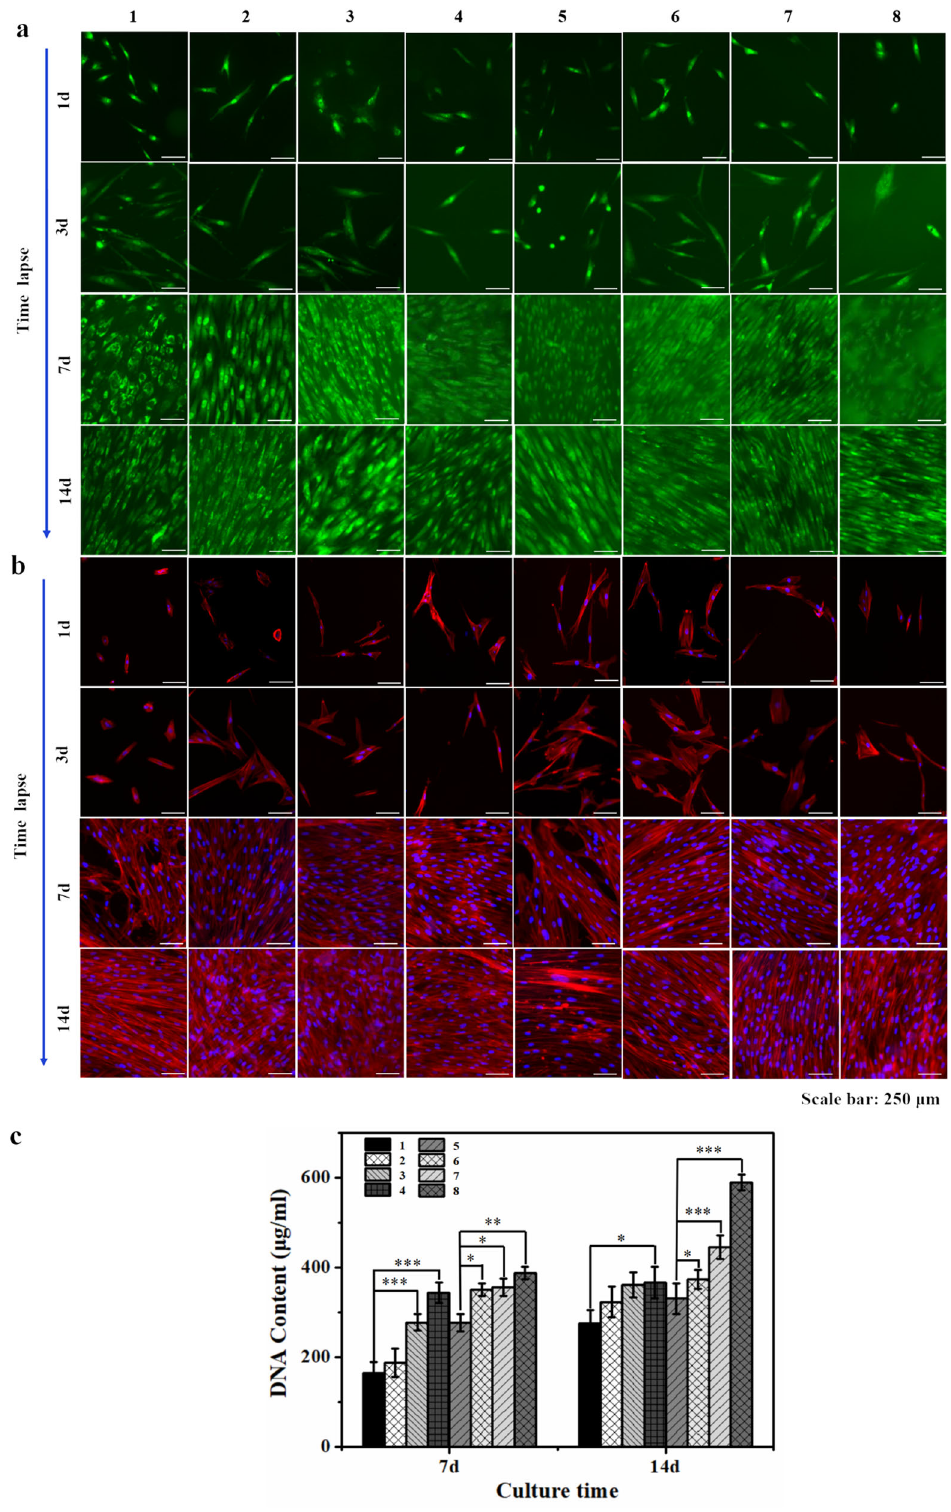
Fig. 4 Analysis of the biocompatibility of hydrogels 1 – 8 in vitro. a Photo micrographs, taken by fl uorescence microscopy, of adherent viable cells in contact with the materials of this study; Live – Dead assay. Horizontal: different materials (1 – 8); vertical: time (1, 3, 7, and 14 days post incubation). See text. b Photo micrographs, taken by fl uorescence microscopy, of adherent viable cells in contact with the materials of this study; Stains: DAPI for cell nuclei and rhodamine for cytoskeleton. Axes like in panel a . c DNA content of the cells that adhered to materials 1 – 8 at two time points (7 days, left; 14 days, right). At both time points, cell viabilities are found to increase in the Series A and B, i.e., with increasing DCM content, see text. (Error bars: ± SD, * p < 0.05, ** p < 0.01, *** p < 0.001). Scale bar = 250 μ